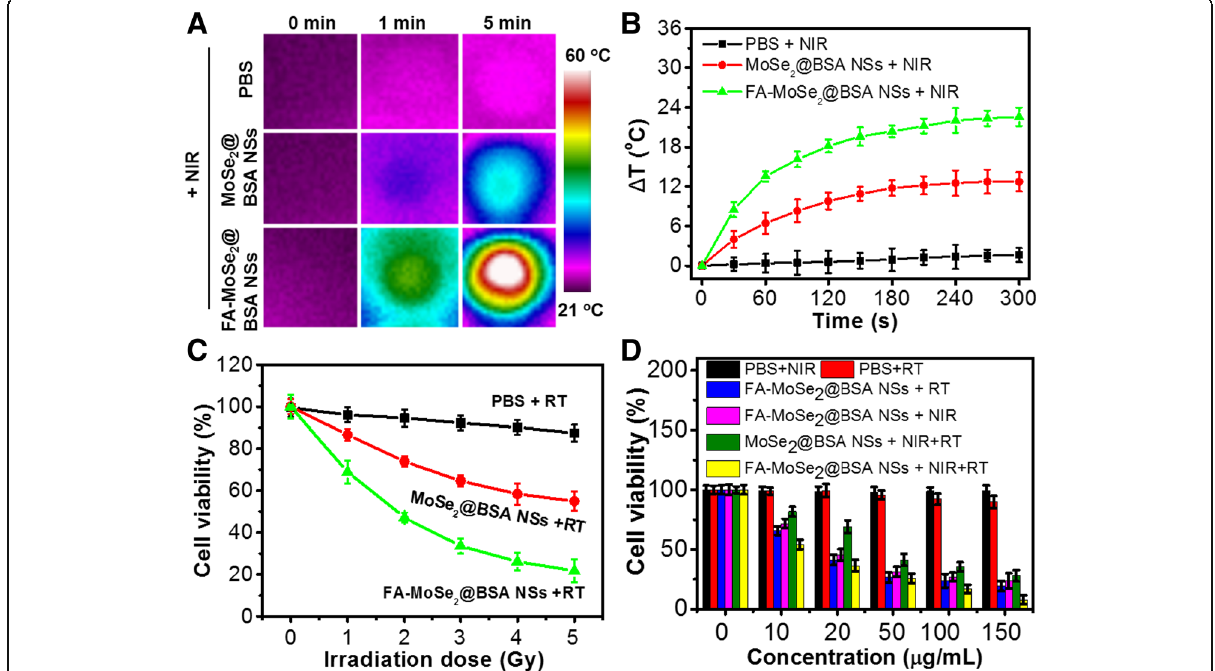
Fig. 5 a Thermal images of PBS, MoSe 2 @BSA NSs and FA-MoSe 2 @BSA NSs treated cells, and b the corresponding temperature change curves under continuous irradiation with an 808 nm laser (1 W/cm 2 ). c Cell viability of 4 T1 cells treated with PBS, MoSe 2 @BSA NSs, and FA-MoSe 2 @BSA NSs combined with different dose of X-ray irradiation (0 – 5 Gy). d Cell viability of 4T1 cells treated with different samples under 808 nm NIR laser (5 min, 1 W/cm 2 ) and X-ray (5 Gy) irradiation